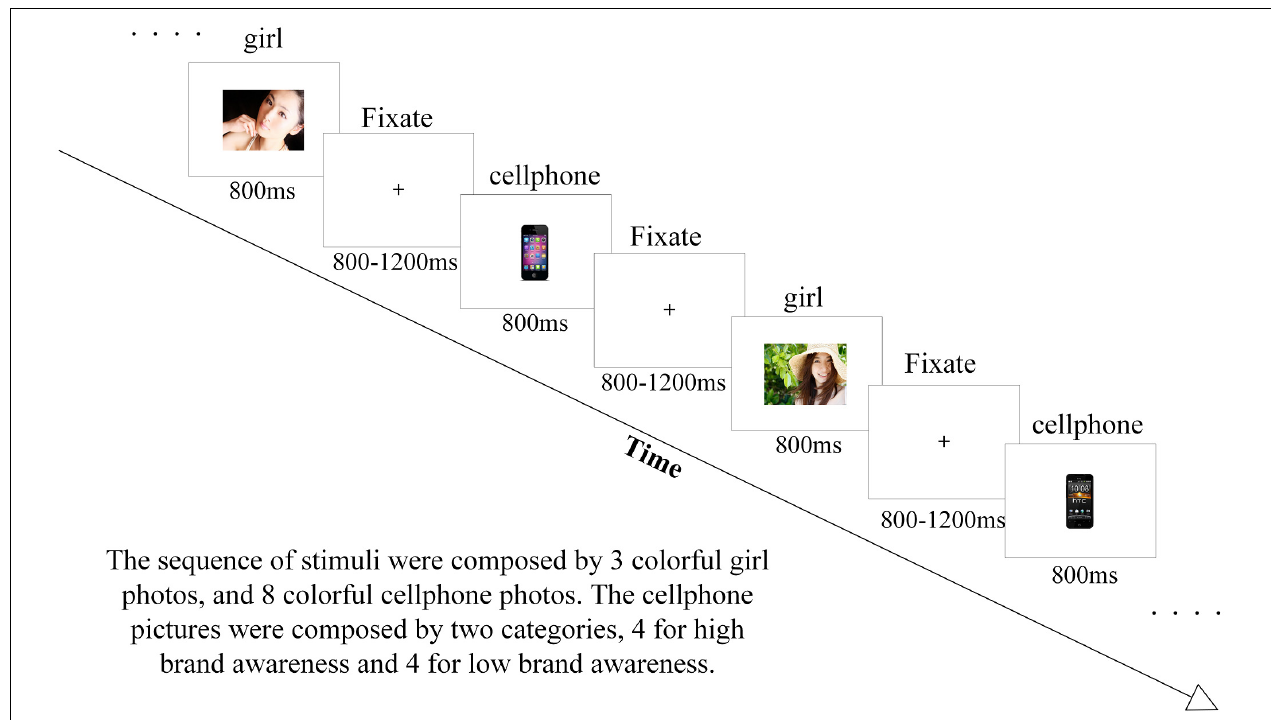
FIGURE 1 | The sequence of stimuli with beautiful girl photos and colorful phone photos in an amended oddball paradigm.